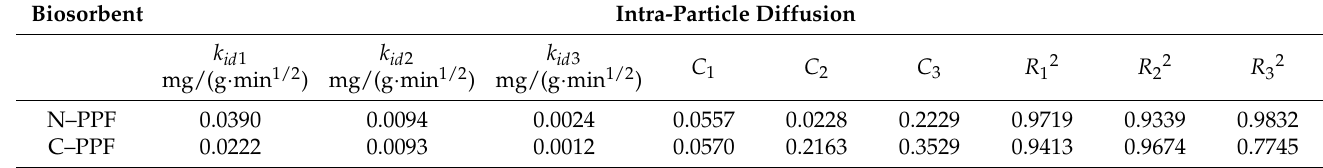
Table 5. Intra-particle diffusion constants of Fe(III) adsorption on different biosorbents at 303 K. Biosorbent Intra-Particle Diffusion